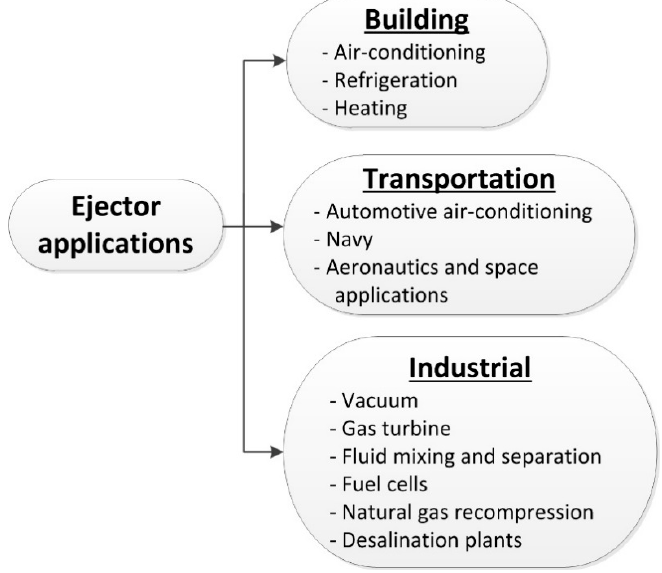
Figure 18. Areas of potential ejector applications.